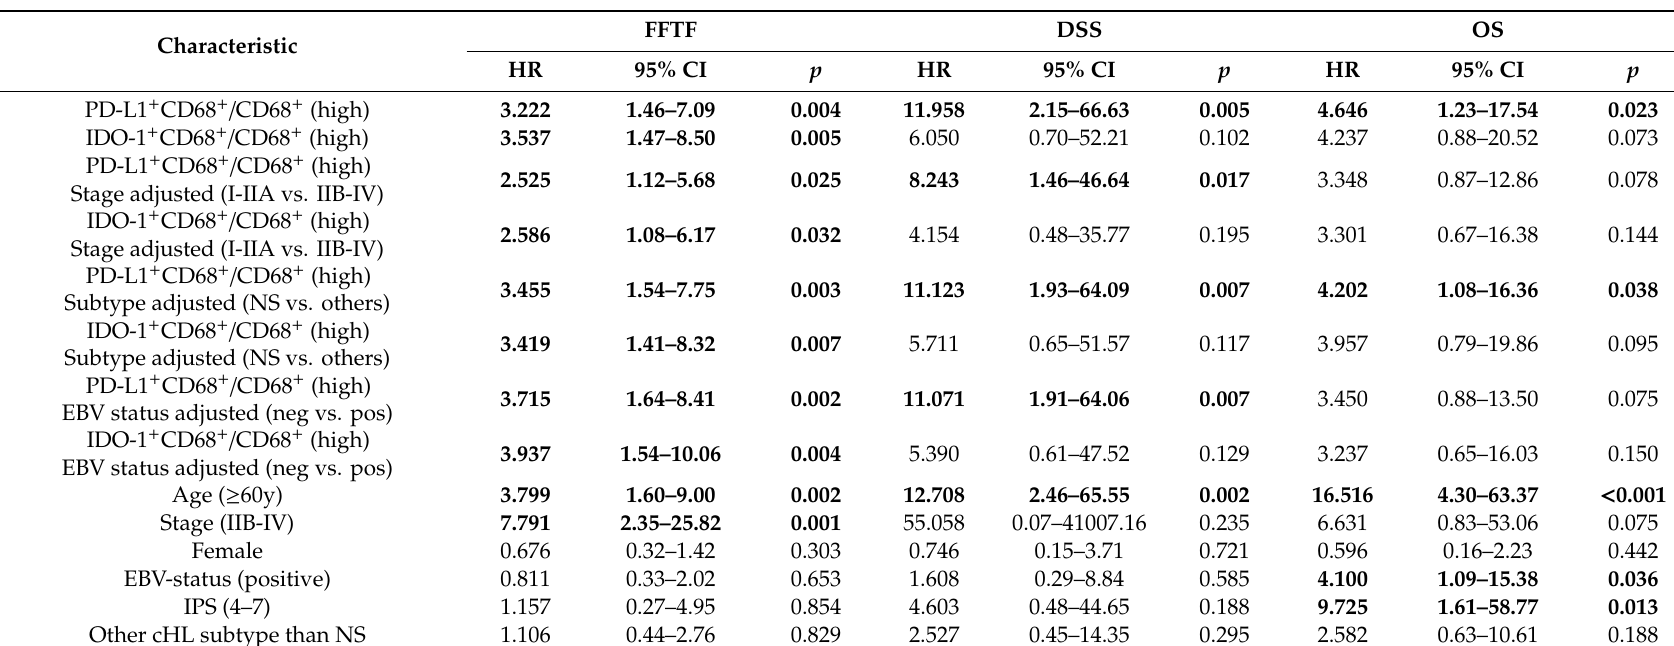
Table 5. Cox regression analysis as categorical variables at univariate level showing association of PD-L1 + CD68 + / CD68 + cell ratio, IDO-1 + CD68 + / CD68 + cell ratio and clinical characteristics of mIHC cohort with FFTF, DSS and